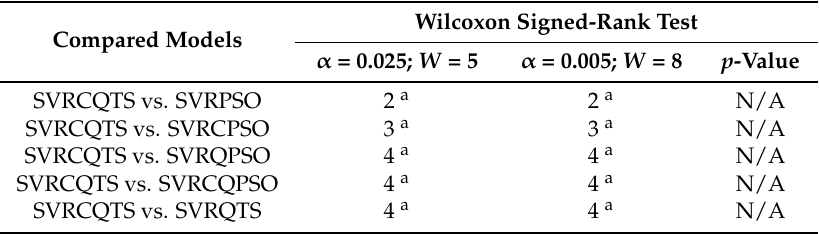
Table 6. Wilcoxon signed-rank test (example 2).